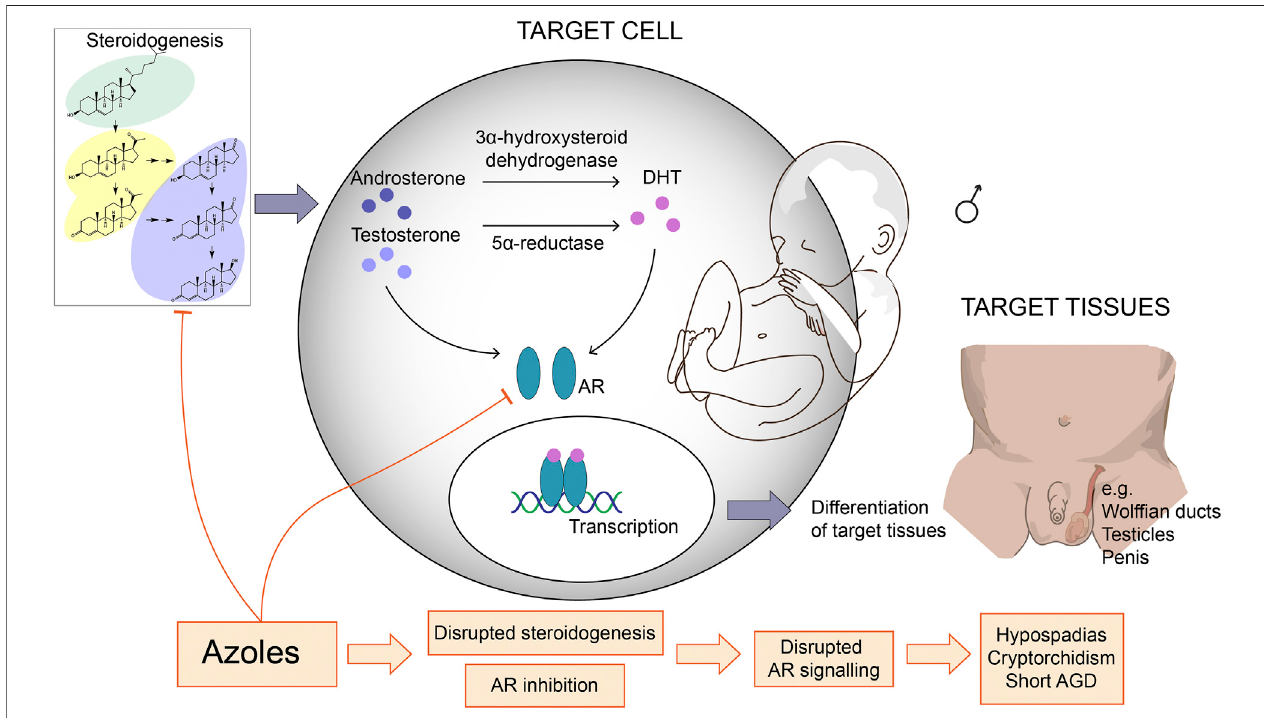
FIGURE 1 | Azole fungicides with anti-androgenic effects and their potential mechanisms of action. Many azole fungicides can inhibit CYP enzyme activity and thereby disrupt steroidogenesis and, ultimately, steroid hormone pro fi les. This may lead to reduced androgen synthesis and signaling in androgen-sensitive target cells. Certainazolescanalso antagonizetheandrogenreceptor (AR)therebyinterferewithARactivationandgeneregulationintarget cells.Since androgensignalingiscrucial for masculinization during development, these molecular effects can impede on male development leading to reproductive disorders. AGD = anogenital distance, DHT =